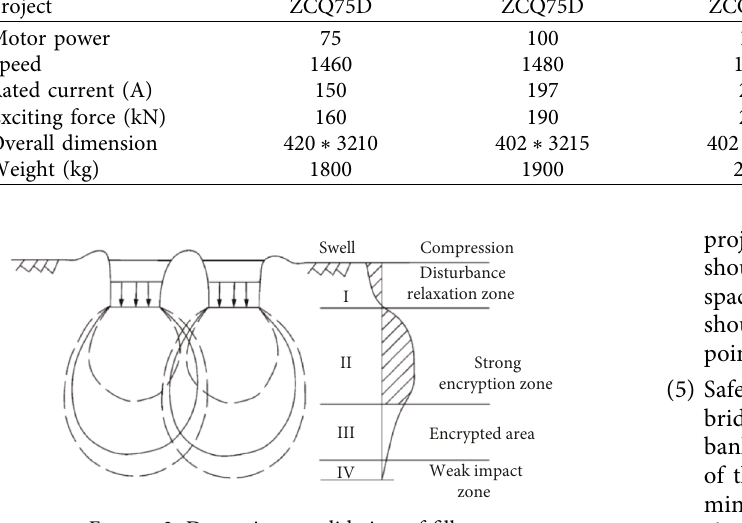
Figure 3: Dynamic consolidation of filler.